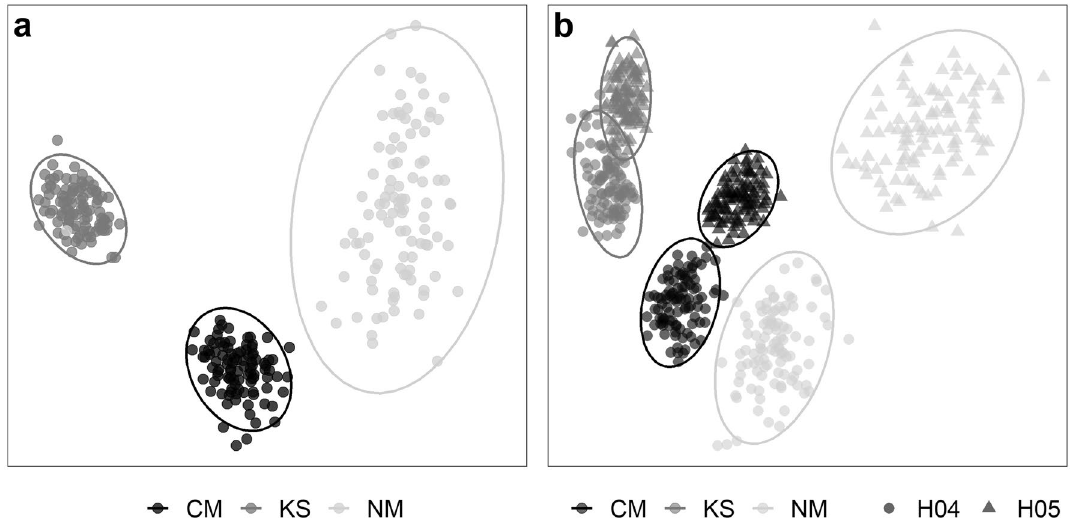
Figure 3. nMDS plots showing regional (between seamounts) and local variations (between habitat types) in faunal assemblage composition. ( a ) Regional assessment based on 100 randomly selected bootstrap-like samples for each study area (seamounts: CM Central Mount, KS Karasik Seamount, and NM Northern Mount) (nMDS stress: 0.09). ( b ) Local assessment based on 100 randomly selected bootstrap-like samples for the two dominant habitat types (H4 = bare rock, H5 = mixed substrate) in each study area (nMDS stress: 0.12). Ellipses represent CI